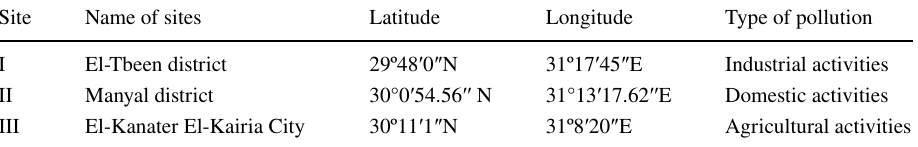
Table 1 Different sites of the investigated area along River